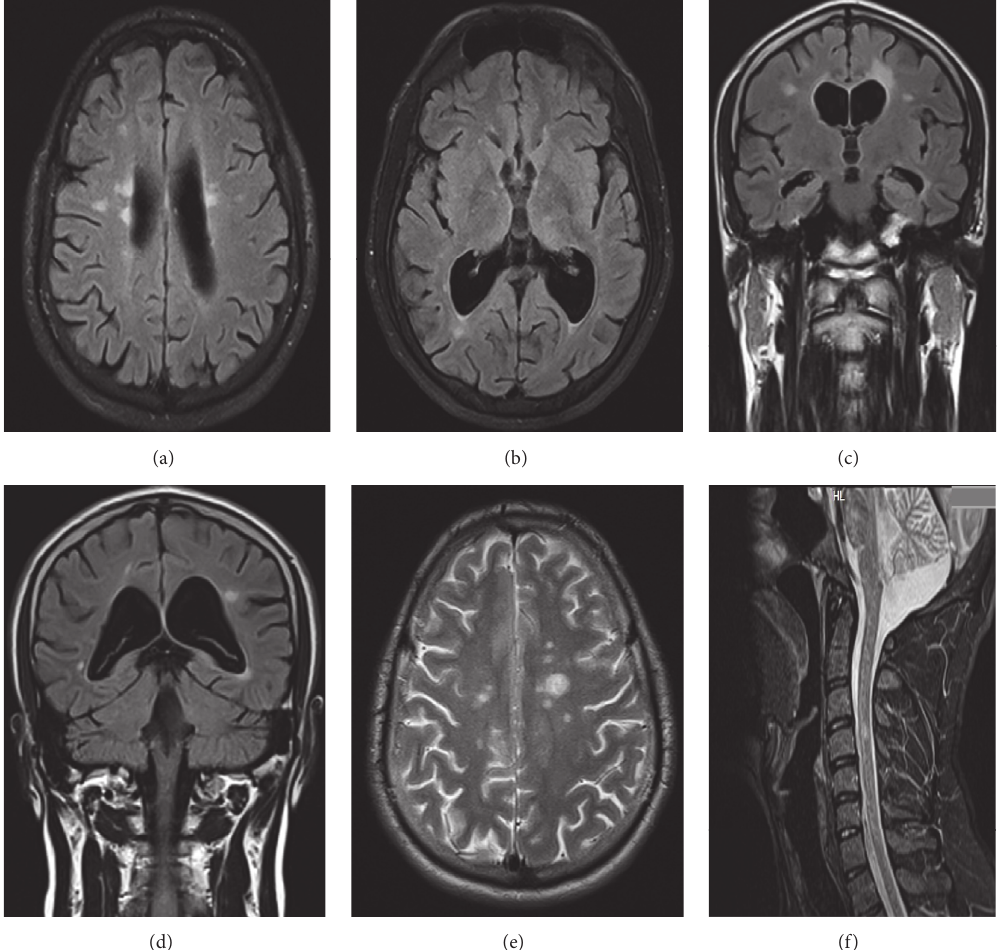
Figure 1: (a, b, c, and d) Flair MRI slices (axial and coronal slices) show periventricular and juxtacortical high intensity lesions. (e) Axial T2 MRI shows multiple juxtacortical high intensity lesions. (f) Sagittal T2 MRI of the cervical spinal cord shows T2 hyperintense lesion at the level of C4.